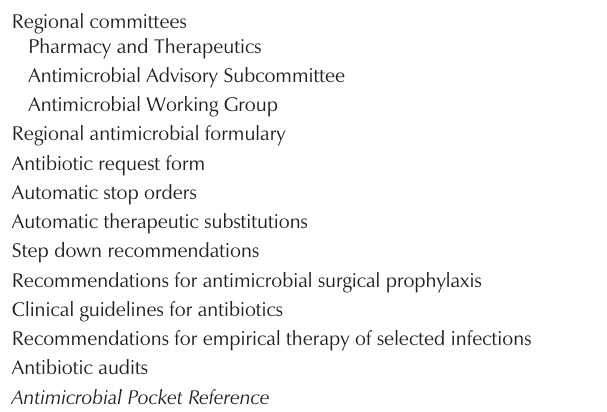
Antimicrobial utilization initiatives in the Capital Health region of Alberta